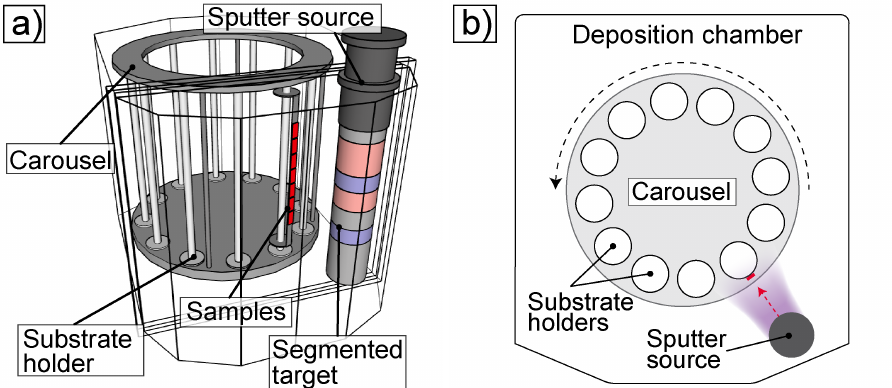
Figure 1. Industrial deposition system which utilizes a segmented cylindrical target as sputter source ( a ) 3D model of the chamber showing the placement of samples on the carousel with reference to the sputter source; ( b ) top-view scheme of the deposition system.